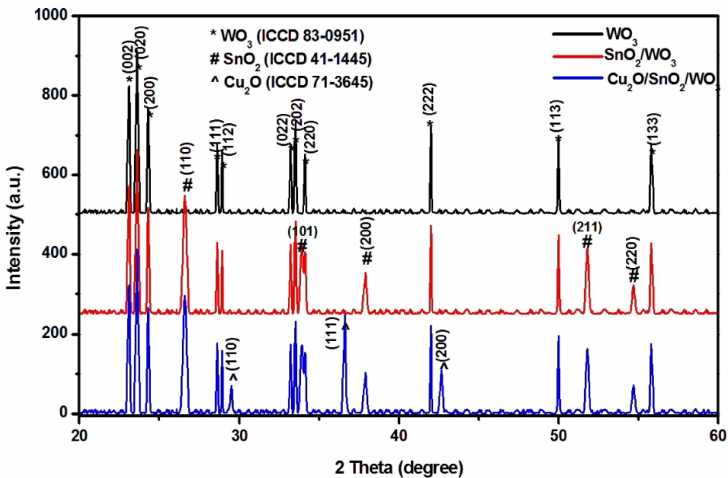
Figure 2. XRD patterns of the photocatalysts. Table 1. Photocatalyst crystallite size values evaluated based on Scherrer formula.